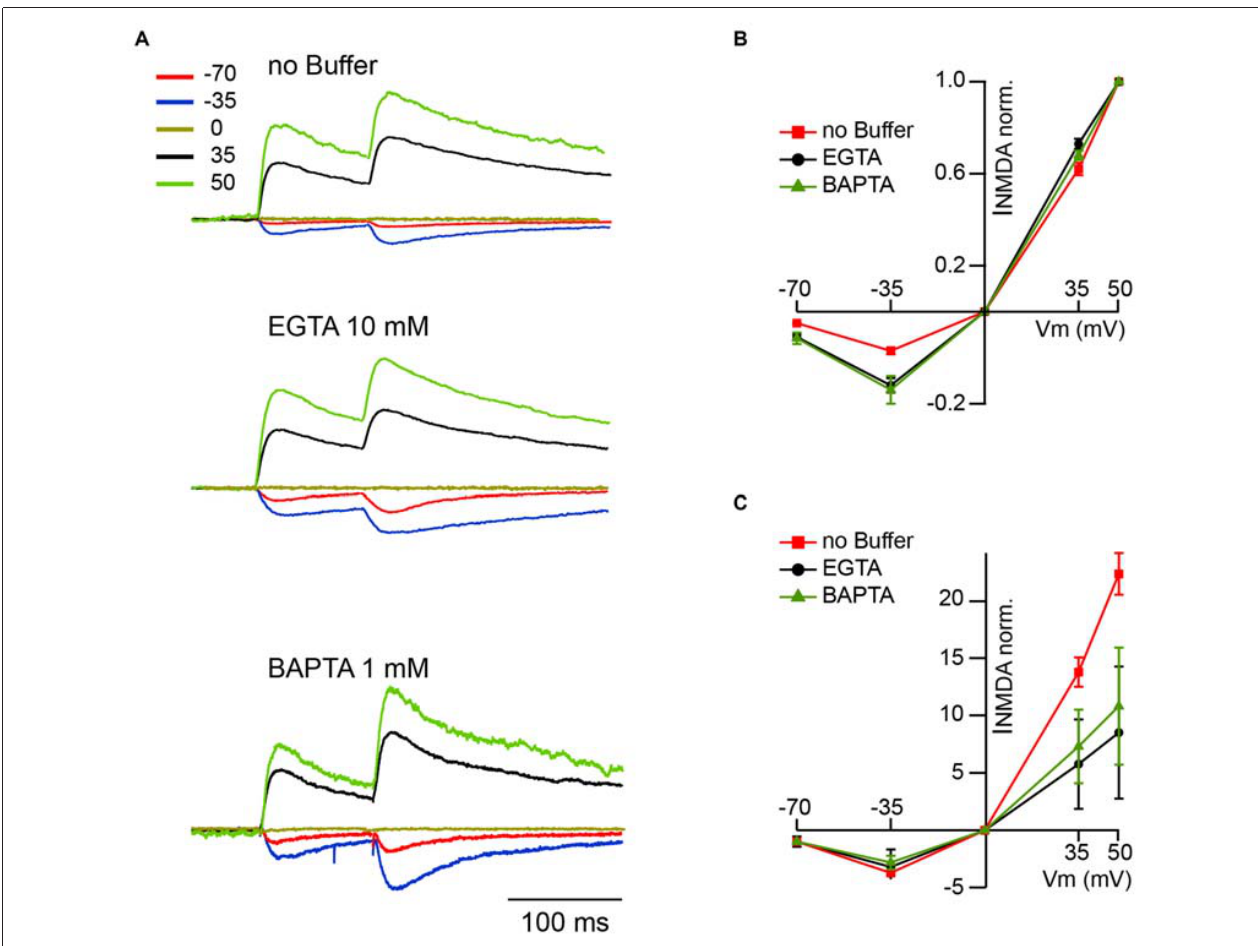
FIGURE 2 | CIIN strongly reduces the amplitudes of nEPSCs at negative potentials, but does not change the voltage dependence of the Mg 2 + block. (A) Normalized (50 mV) synaptically evoked NMDAR-mediated responses recorded at − 70, − 35, 0, 35 and 50 mV from CA1 pyramidal cells dialyzed with buffer-free, EGTA- or BAPTA-containing intracellular solutions. (B,C) Current voltage relationships of nEPSCs normalized to the amplitudes at 50 mV (B) and − 70 mV (C) obtained with buffer-free (red), EGTA- (black) and BAPTA-containing (green) intracellular solutions.